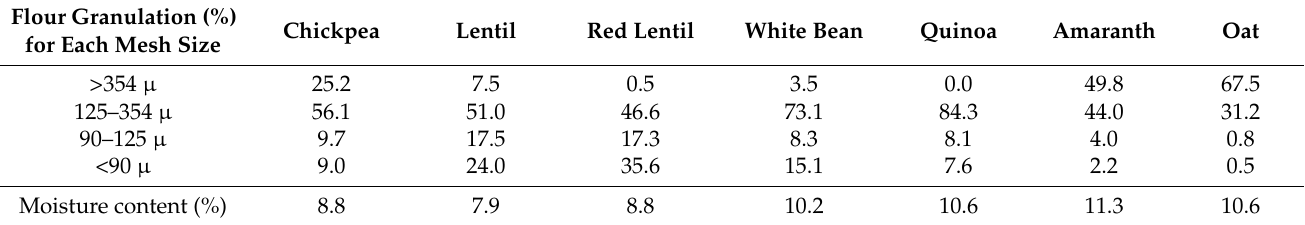
Table 1. Flour particle size distribution (%) and moisture content